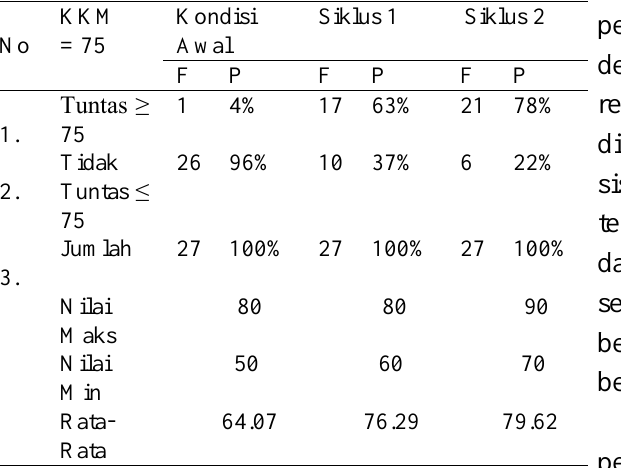
Tabel 1. Hasil Proses Pra, siklus I, dan siklus